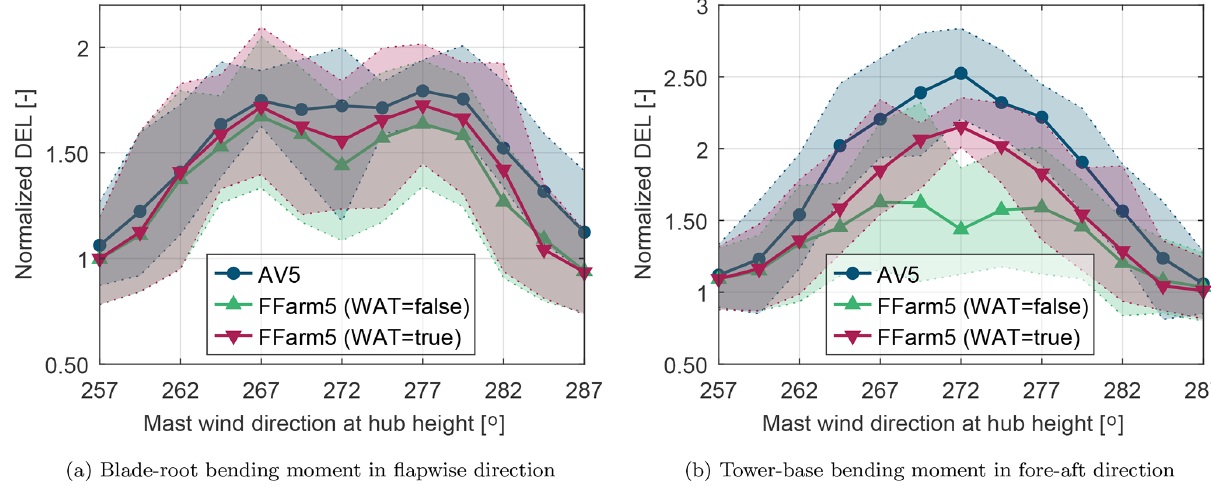
Figure A1. Comparison of FAST.Farm simulations with activated (WAT = true) and deactivated (WAT = false) wake-added turbulence with respect to the measurements (AV5) for wind speeds of 7.5–8.5ms − 1 . Statistics are shown as mean values per wind direction bin. The shaded area indicates the 15th and 85th percentiles.